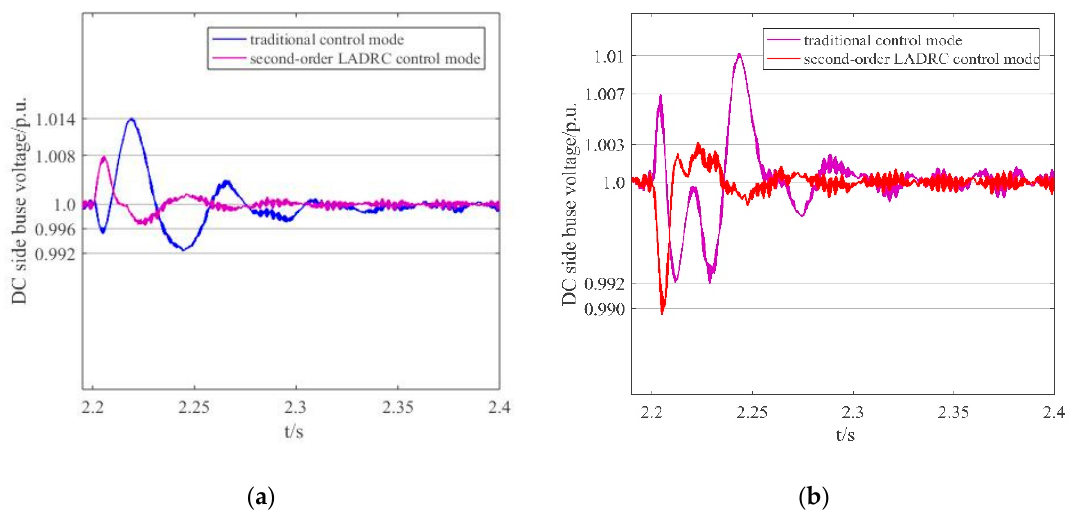
Figure 12. DC side bus voltage comparison waveform when the motor load suddenly changes. ( a ) DC side bus voltage comparison waveform when the motor load suddenly increases; ( b ) DC side bus voltage comparison waveform when motor load suddenly decreases.